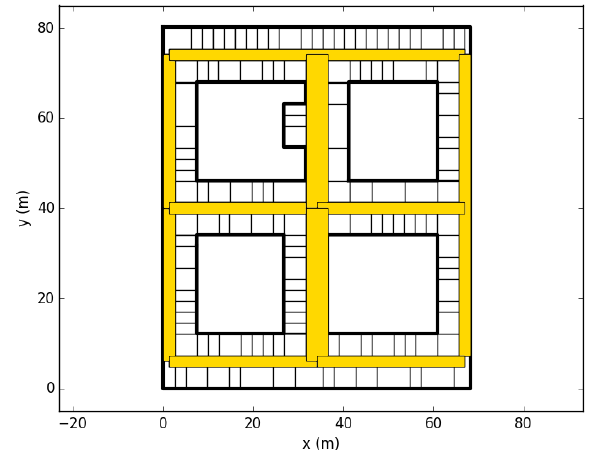
Figure 7. A result from our